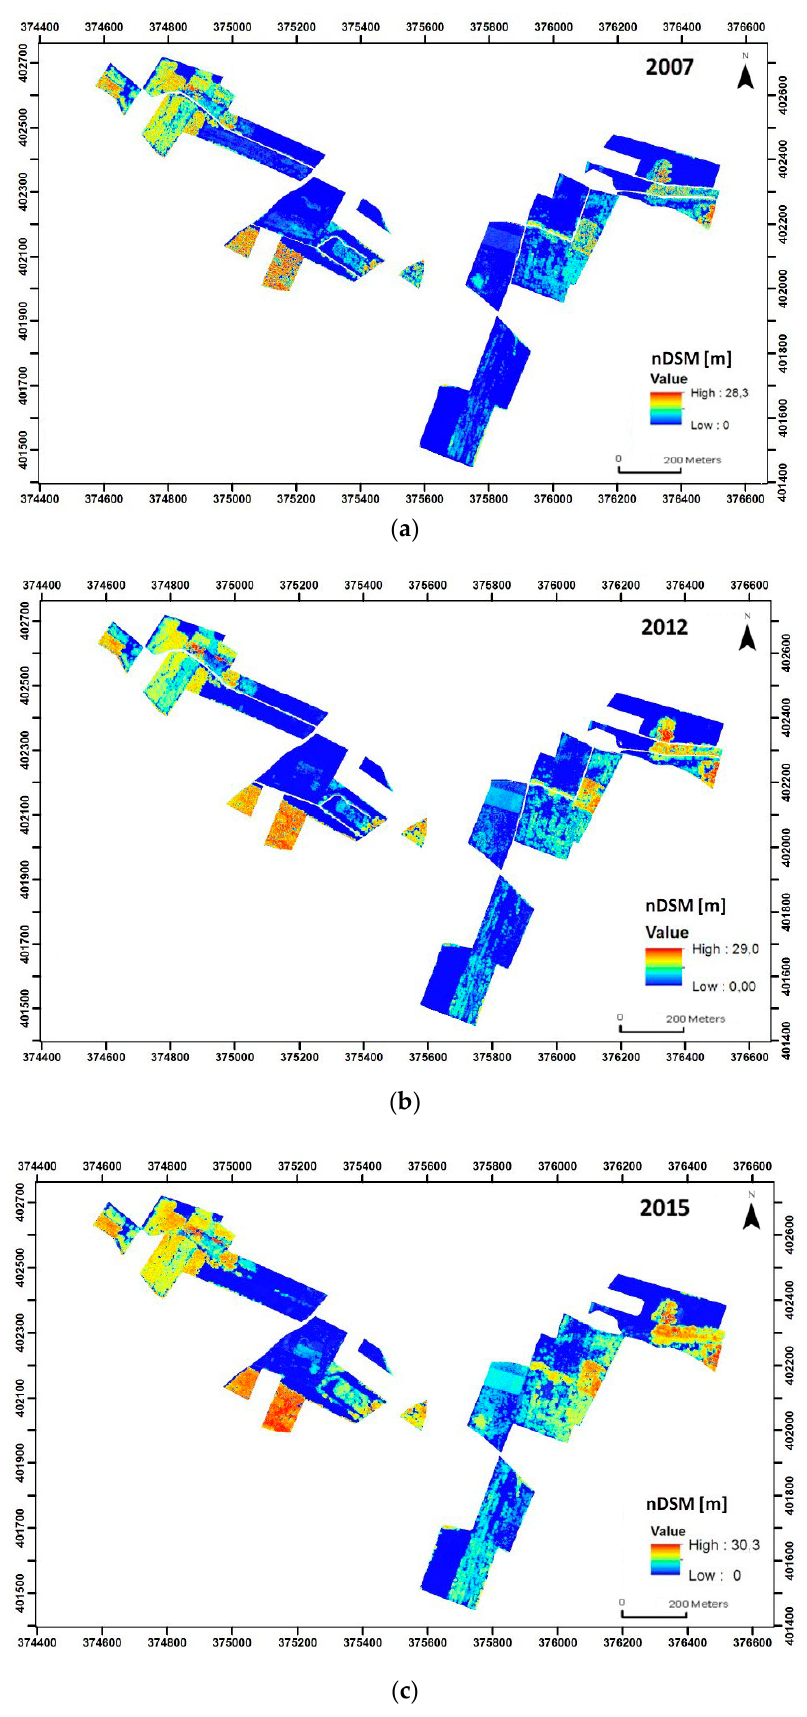
Figure 3. The graphic results of airborne laser scanning (ALS) point cloud processing—nDSM: ( a ) 2007; ( b ) 2012; ( c ) 2015.